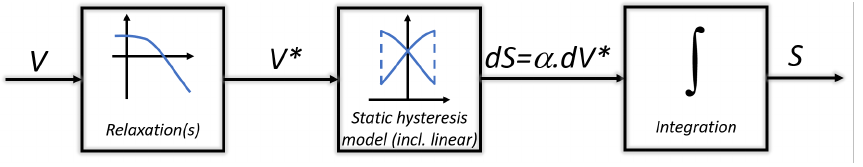
Figure 2. Global model